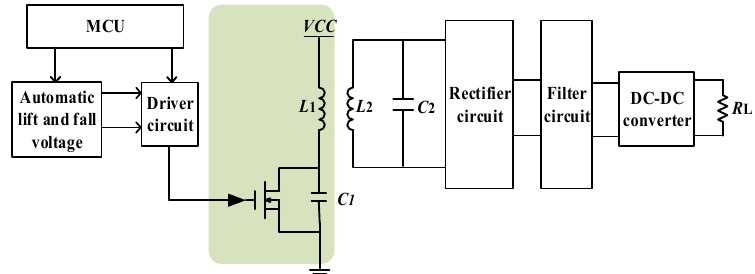
Figure 1. Block diagram of system structure.